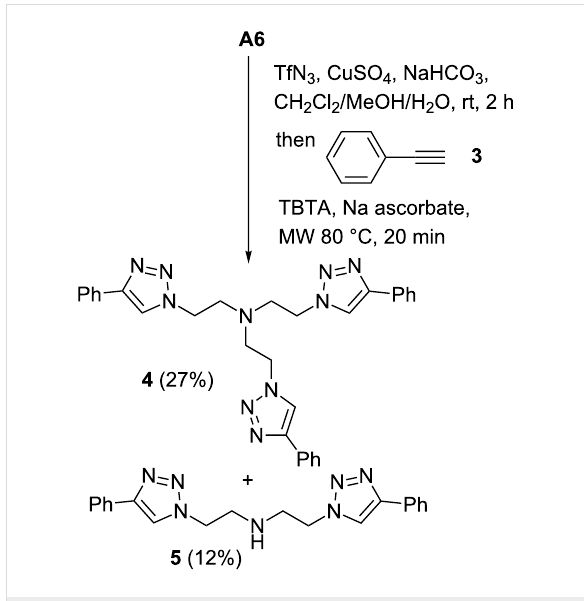
Scheme 3: Formation of side-product 5 during the synthesis of 4